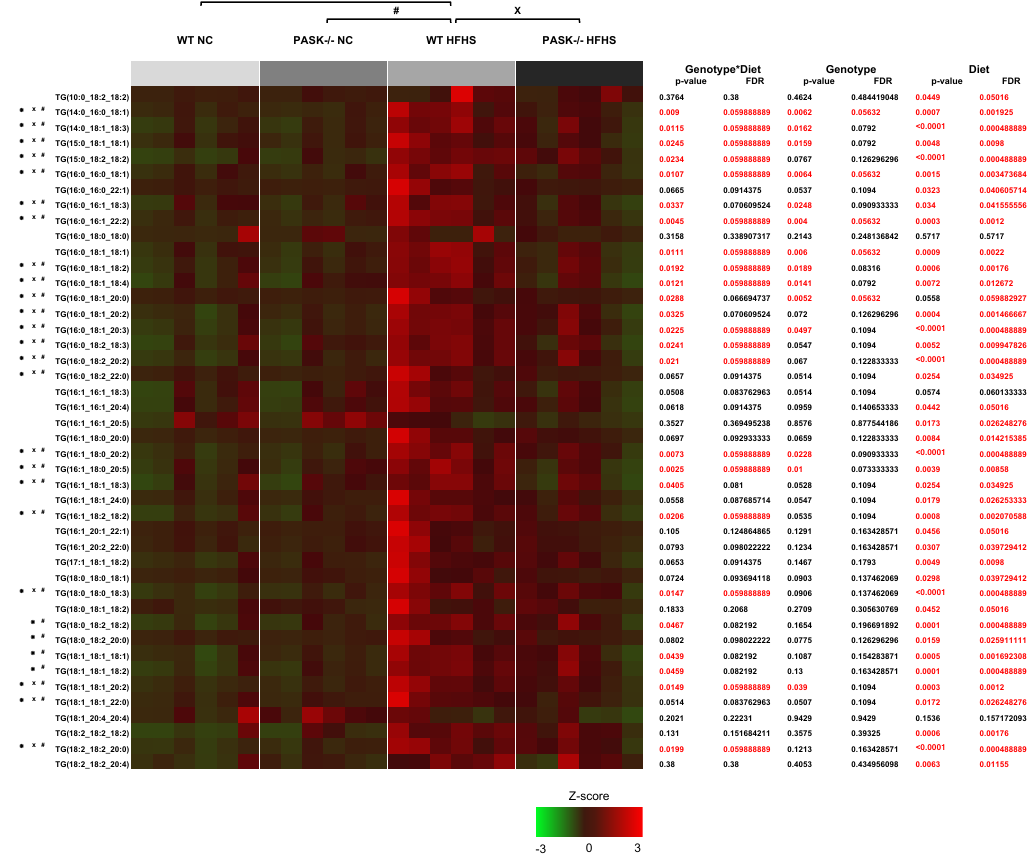
Figure 4. LC/MS triglyceride analysis of WT and PASK − / − male mice on NC and HFHS reveal significant changes in individual triglycerides. A heat map LC/MS triglyceride analysis from male WT and PASK − / − mice placed on a NC and HFHS diet ( n = 6 for each of 4 sample groups) *, #, or X, p < 0.05 when analyzed by two-factor ANOVA and Tukey post-hoc test. Two-factor (genotype and diet) and one-factor (genotype or diet) interaction analysis is provided in a table on the right with p -values and false discovery rates (FDR) given. Significant p -values ( p < 0.05) are shown in read, with alternative FDR q -value cutoff ( p < 0.0599) provided in red for